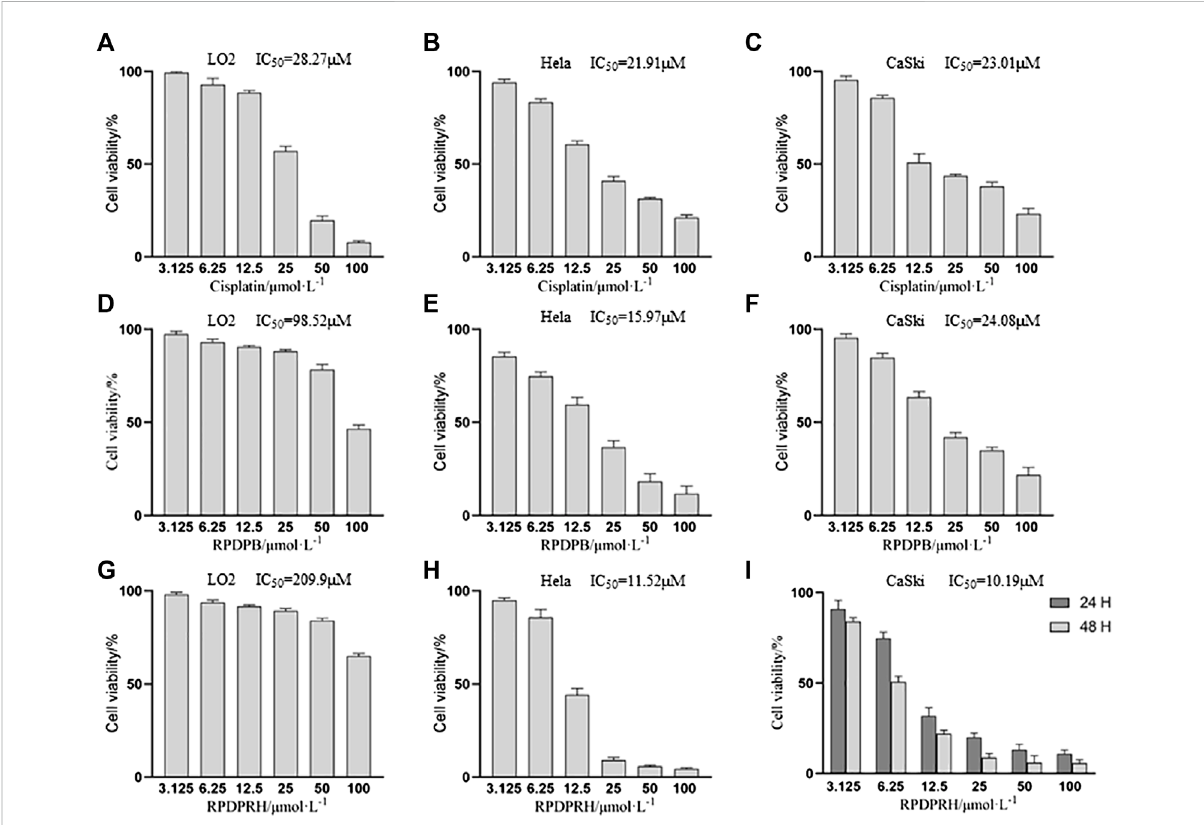
FIGURE 2 Anti-proliferative activities of Cisplatin, RPDPB and RPDPRH on Hela, LO2 and CaSki cells, respectively. Note: (A – C) : Cell activity of LO2, Hela and CaSki cells treated with Cisplatin for 48 h (D – F) : Cell activity of LO2, Hela and CaSki cells treated with RPDPB for 48 h (G, H) : Cell activity of LO2 and Hela cells treated with RPDPRH for 48 h (I) : Cell activity of CaSki cells treated with RPDPRH for 24 and 48